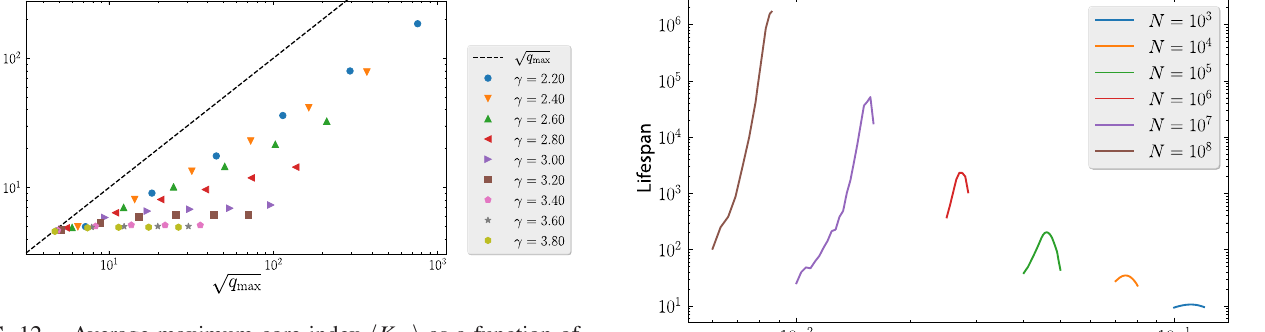
as a function of M i FIG. 13. Average lifespan vs spreading rate λ starting from a single infected node (the hub) and reaching the healthy absorbing state before the coverage reaches the threshold value c ¼ 0 . 5 . Data are for LPA networks with γ ¼ 2 . 6 and various system size N